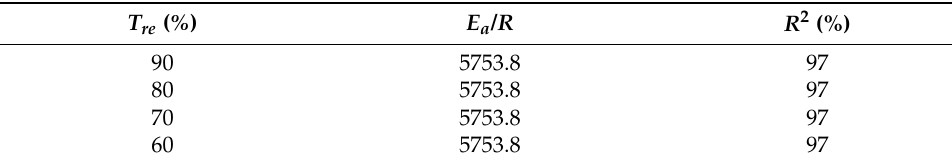
Table 12. Values of 𝐸 (cid:3028) 𝑅⁄ (G2) based on the third prediction model.